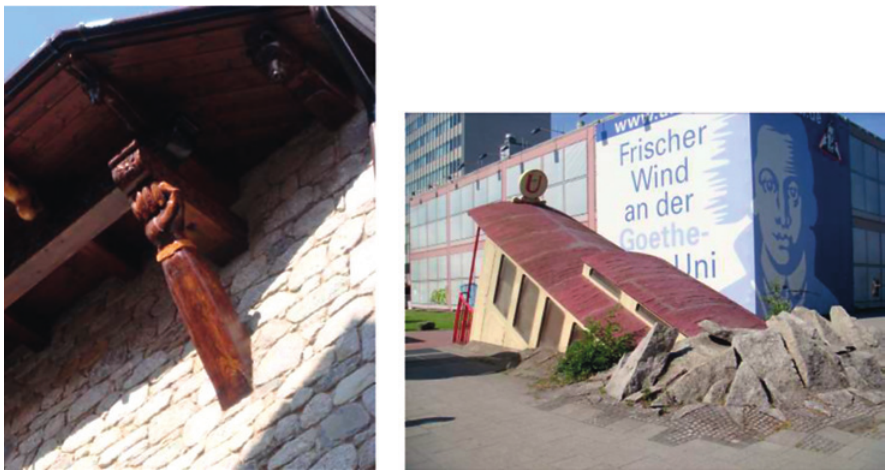
Fig. 40. Traditional constructive techniques of the Pyrenees combined with a more modern wrist watch.